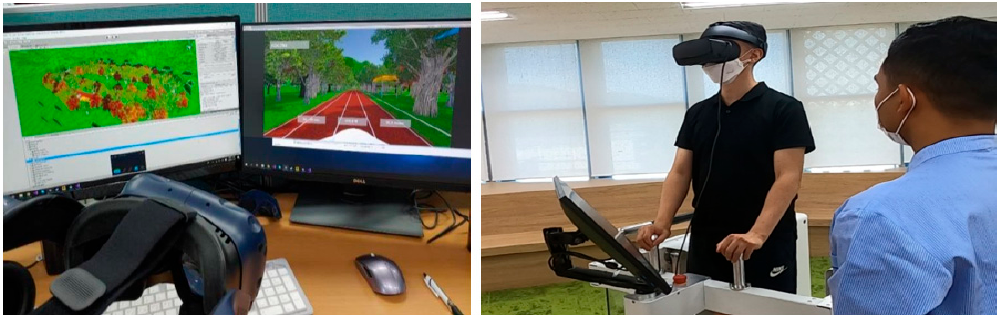
Figure 5. Application of VR system.